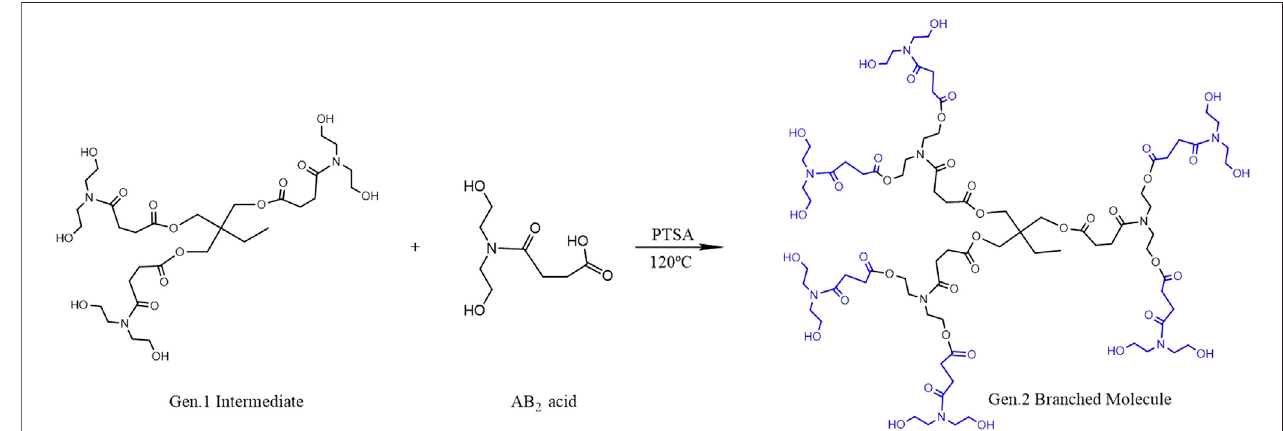
FIGURE 2 | Synthesis of Gen. 2 hyperbranched polyurethane (HPAE).